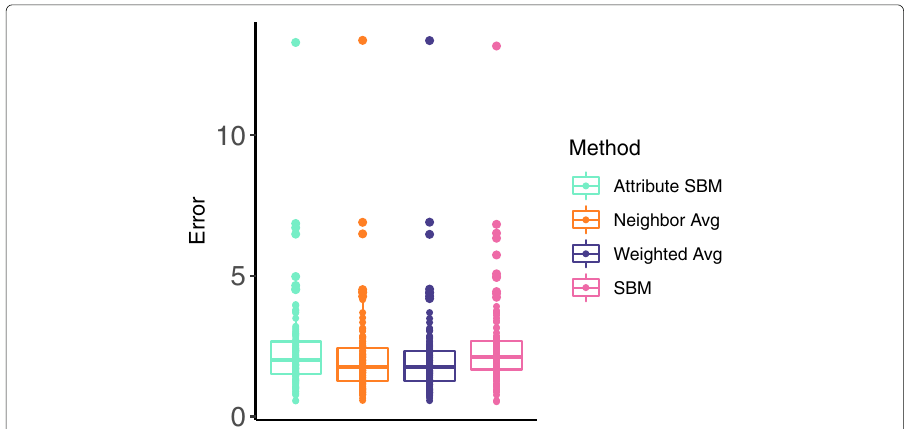
Fig. 6 Collaborative Filtering Accuracy in Microbiome Subject Similarity Network: For each of the 121 nodes, we fit a model to the remaining 120 node network and given the node’s closest neighbors (based on network connectivity) sought to predict its 5-dimensional attribute vector. The reported error is the root mean squared error (RMSE) (denoted by E ) between the true attribute vector ( x i ) and its predicted attribute vector ( ˆ x i ) . The mean root squared error in the attributed SBM is 2.3, as opposed to the neighbor average, weighted neighbor average and SBM having mean errors of 2.06, 2.05, and 2.45,